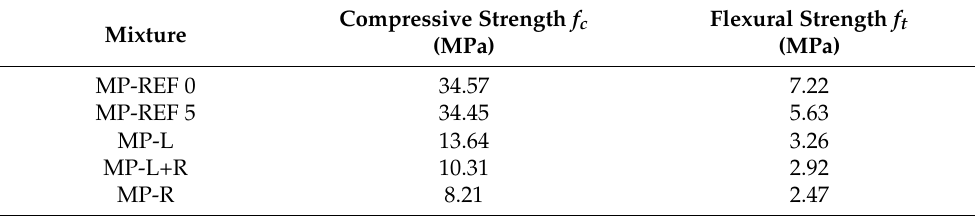
Table 11. Mechanical parameters of hardened mortars at the age 14 days.